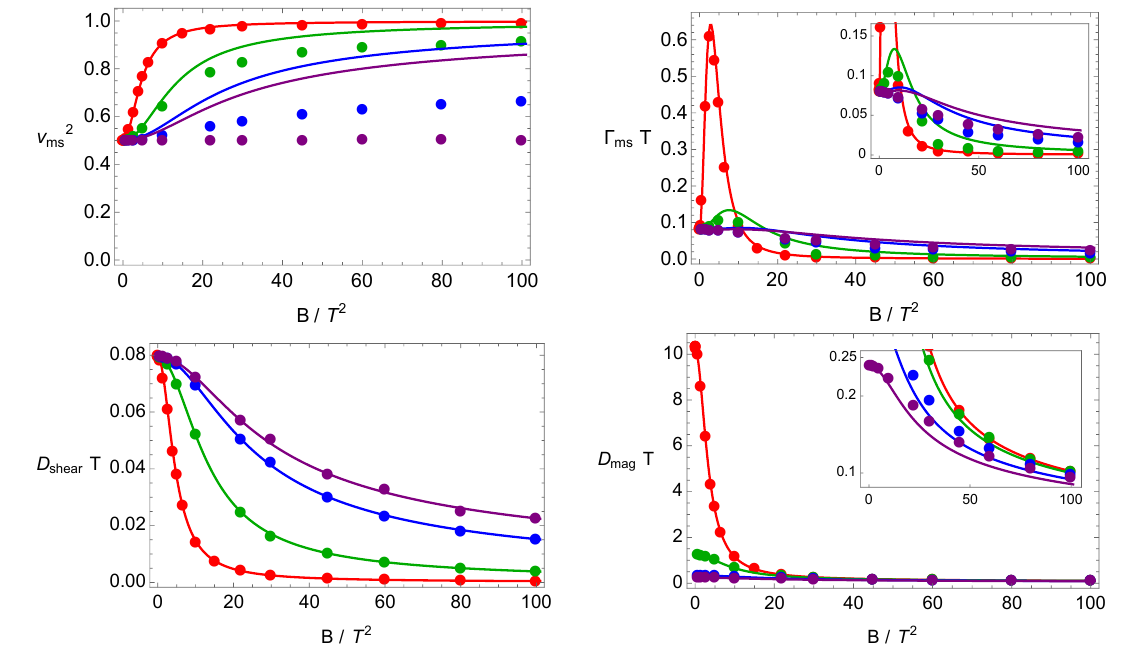
Figure 15 . Top: speed and attenuation constant of magnetosonic waves. Bottom: the diffusion constants of shear and magnetic diffusion. The colors correspond to λ/T = (0.1, 1, 10, 1000) (red, green, blue, purple). The insets are a zoom for the large λ case (e.g., purple).